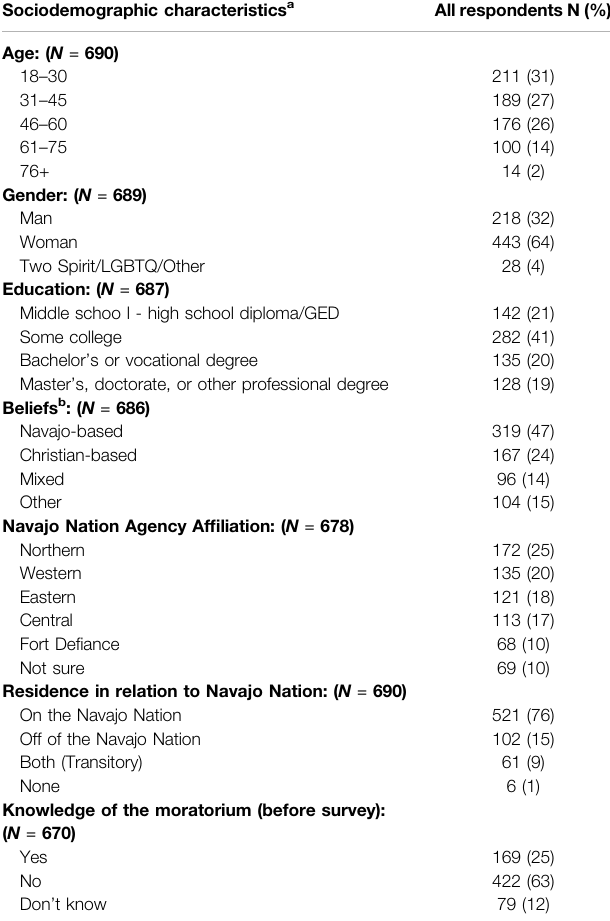
TABLE 1 | Characteristics of Navajo respondents to the survey. Sociodemographic characteristics